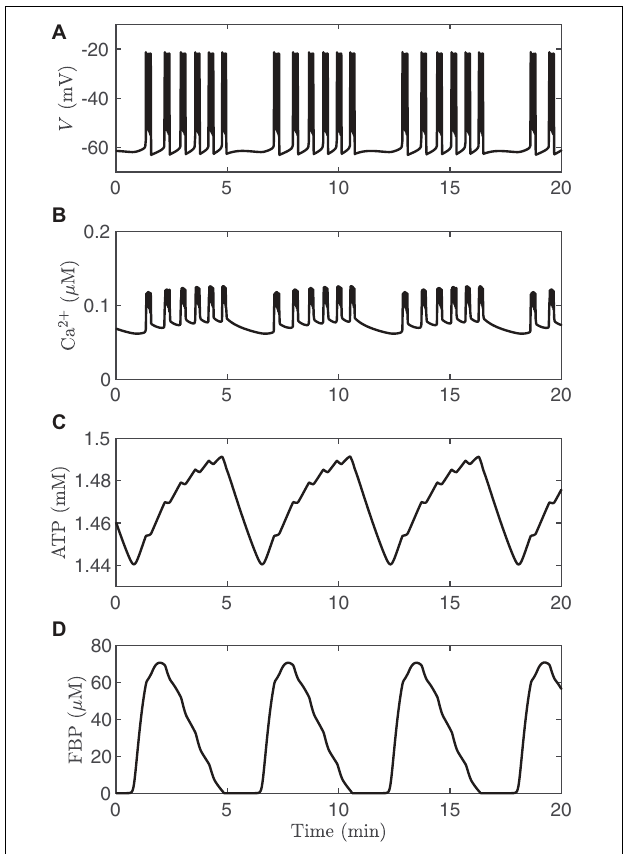
FIGURE 7 | Compound bursting generated by the IOM, and the calcium time courses are similar ( Figures 9A,B ). (A) Membrane potential. (B) Cytosolic calcium. (C) ATP. (D) FBP. For this simulation, v PDH = 2 µ M / ms, g K ( Ca ) = 600 pS, and the glucose concentration in 11 mM.